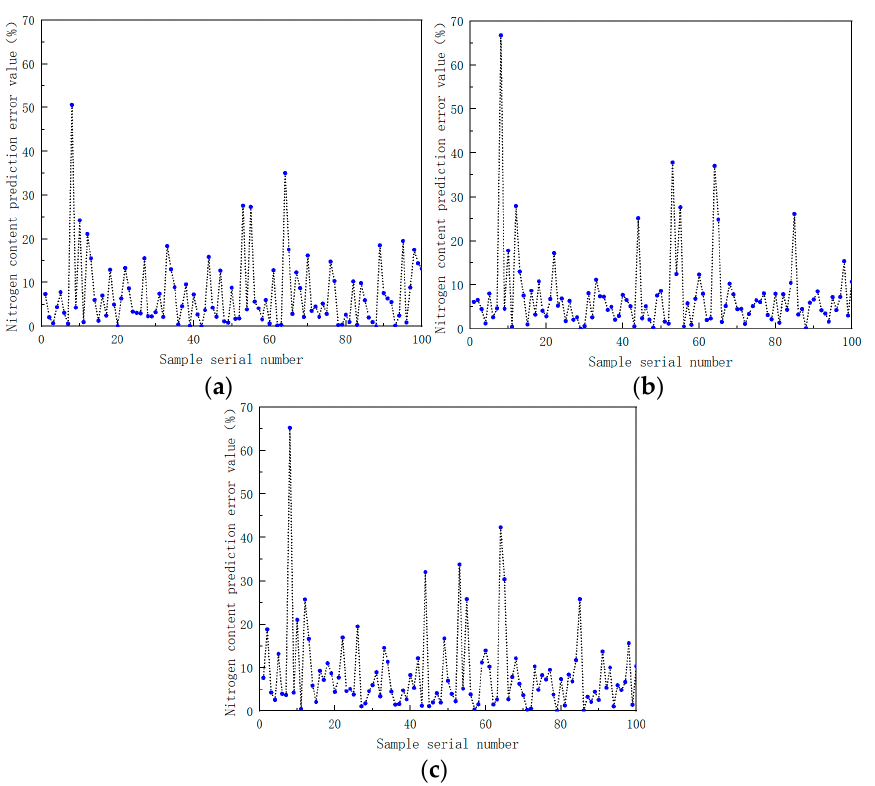
Figure 17. ( a ) Prediction results of soil nitrogen content using back propagation neural network based on Levenberg–Marquardt training function; ( b ) prediction results of soil nitrogen content using back propagation neural network based on Bayesian regularization training function; ( c ) prediction results of soil nitrogen content using back propagation neural network based on scaled conjugate gradient training function.